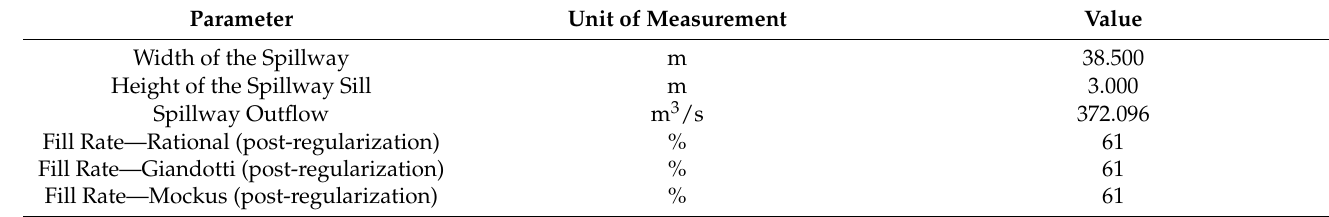
Table 7. Application of the Cipolletti spillway.